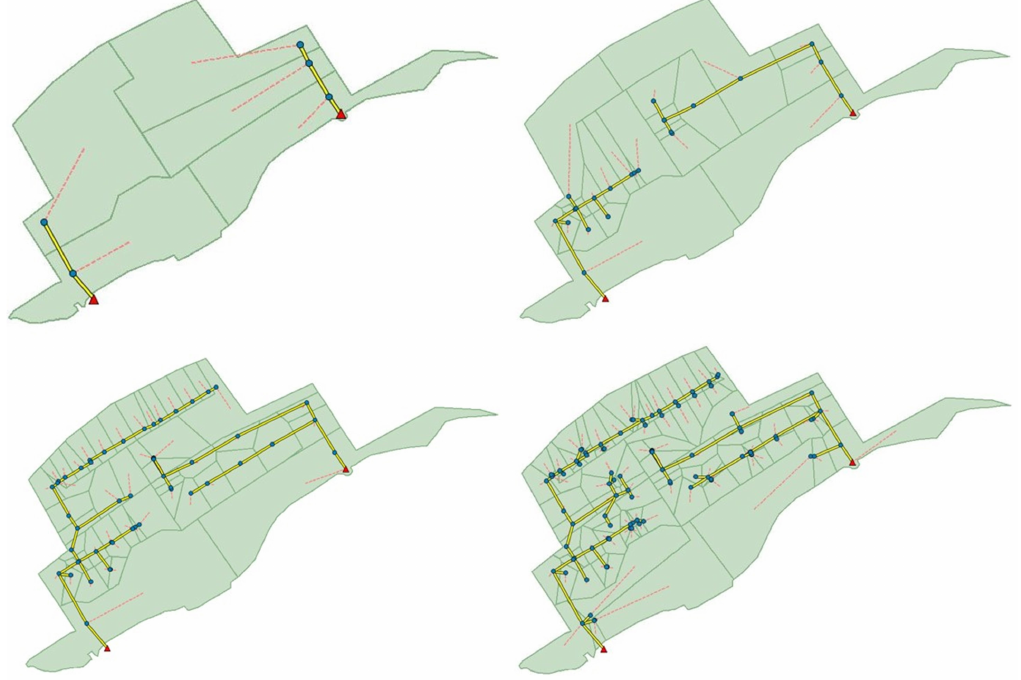
Figure 9. Classification results for four levels of the sewer network and the corresponding discretization results for the convention